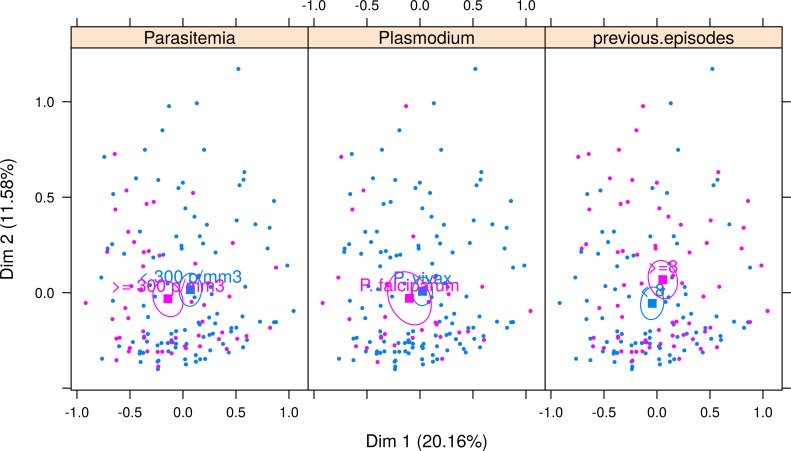
Multiple correspondence analysis classified by Plasmodium species, parasitemia and number of previous malaria episodes.The confidence ellipse delimitates the centroid around each variable. For Parasitemia, ellipses are separated, indicating a good distinction in symptom profile between low and high parasitemia. Patients with higher parasitemia (≥300 parasites/mm3) have more symptoms (pink ellipse is seen in the left-hand side of dimension 1) and those with lower parasitemia (<300 parasites/mm3) tend to have fewer symptoms (blue ellipse represented on the right-hand side of dimension 1). For Plasmodium species, ellipses are superimposed, indicating that the symptom profile shown in each type of malaria is very similar, and therefore malaria species cannot be differentiated using symptoms only. For number of previous episodes of malaria, there is little superimposition of the ellipses, indicating that it is possible to separate between those patients with more than eight previous malaria episodes, who generally experience fewer symptoms (pink ellipse is in the right side of Dimension 1, indicating less symptoms), except for symptoms sore throat, which is more pronounced in these patients (note that the pink ellipse is above the blue ellipse in Dimension 2, indicating that symptoms distributed along dimension 2 are differentiating patients with 8 or more episodes from those with less than 8 episodes).